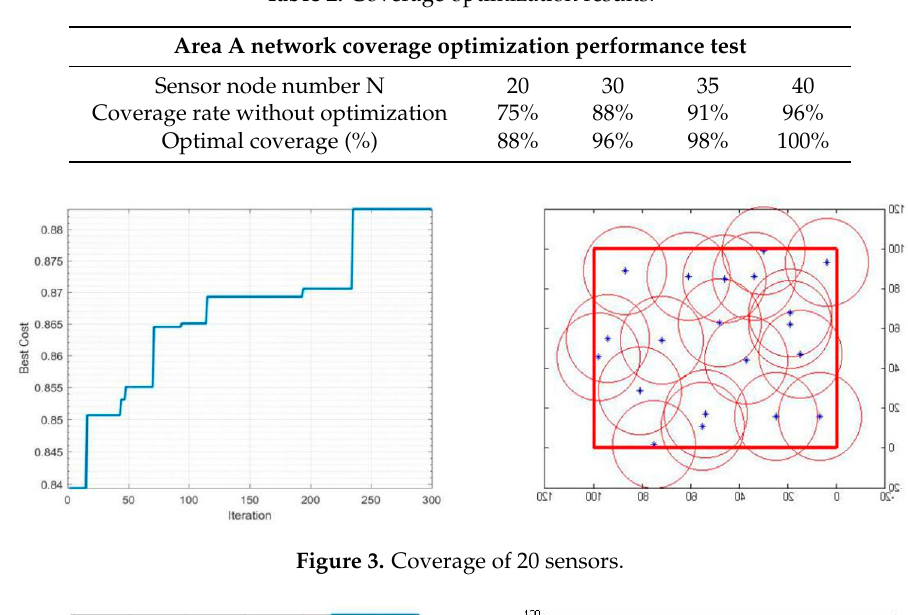
Table 2. Coverage optimization results.